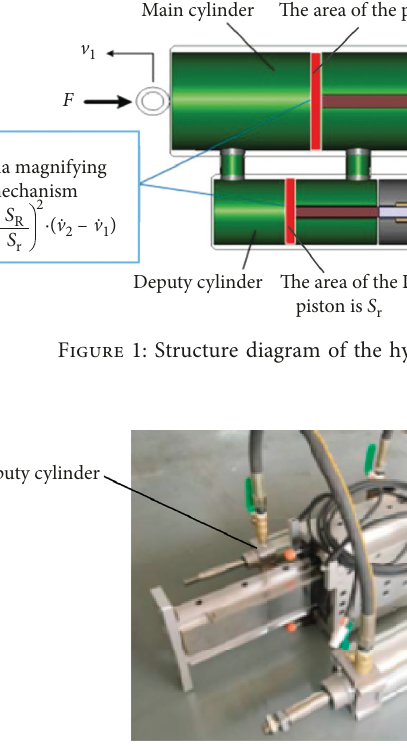
Figure 2: Prototype diagram of the hydraulic electric inerter. Table 1: Parameter information of the hydraulic electric inerter.